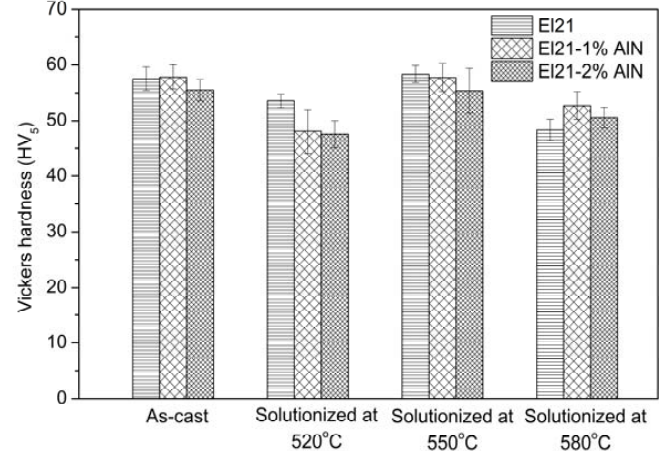
Figure 11. Hardness values of El21, El21–1.0 wt.% AlN and El21–2.0 wt.% AlN as cast and solution treated at different temperatures.